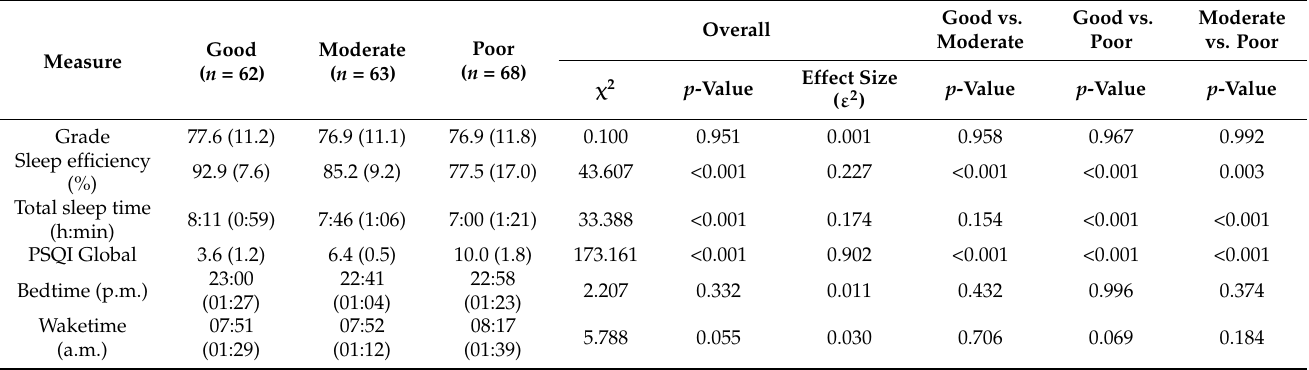
Table 1. Comparison between students with good ( ≤ 5 in PSQI) moderate (6–7 in PSQI) and poor ( ≥ 8 in PSQI) sleep quality. Data shown as means (SD).